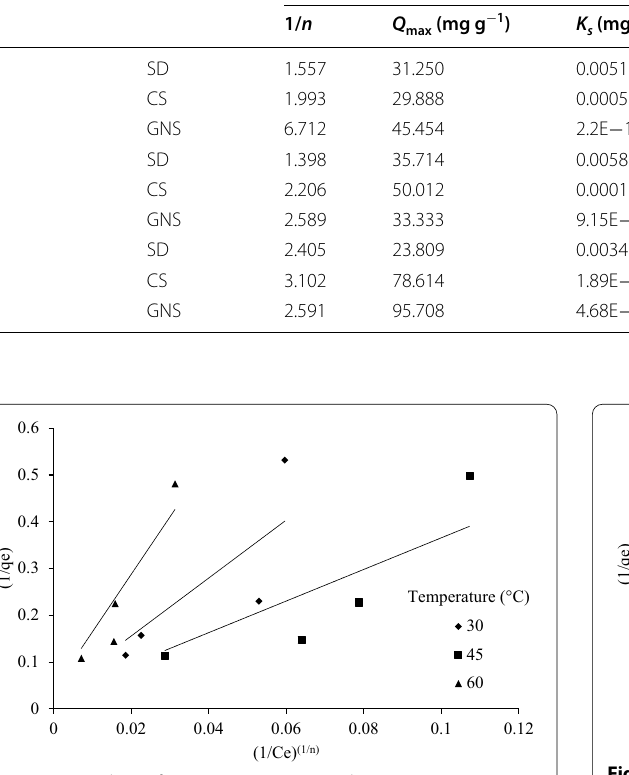
Table 4 Value of Sips constants for SD, CS and GNS at 30 °C, 45 °C and 60 °C and %Improvement due to Sips isotherm Temperature (°C)